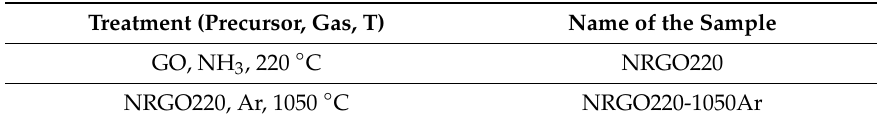
Table 1. Designation chosen to distinguish the samples according to the corresponding synthesis, namely, ammonolysis of GO or post-synthesis thermal